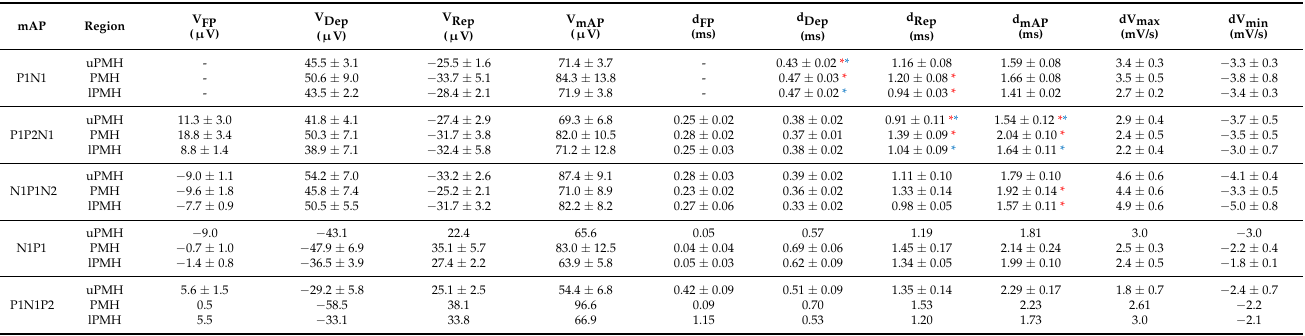
Table 2. Properties of types of mAP across the three